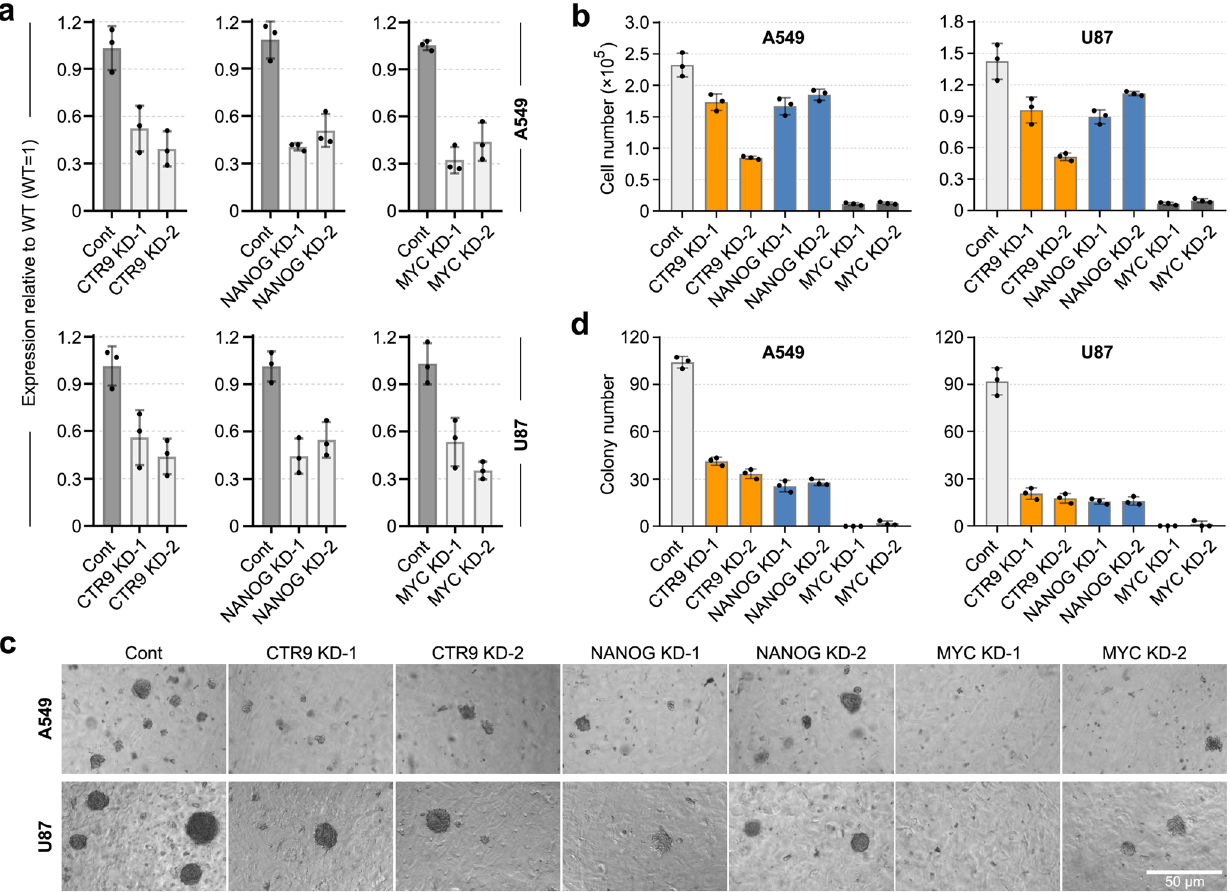
Fig. 9 The functional analysis of CORE, MYC and PAF modules in cancer cells. a qRT-PCR analysis for the knocking down of indicated gene expression in A549 and U87 cells. The major transcriptional factors of each module, Ctr9 (PAF), Nanog (CORE) and Myc (MYC), were chosen for functional analysis. Cells were infected with lentivirus carrying control and shRNAs targeting the indicated genes respectively. All data is normalized to Gapdh and shown relative to WT ESCs (set at 1.0). b The indicated cells (2000 cells per cm 2 in 6-well plates) were cultured for six days and cell numbers were counted. c The morphology of colonies formed by the indicated cell lines. Cells (1000 or 2000 cells in 48-well plates) were grown for 10 days. Scale bar, 50 μ m. d Quantitative analysis of the colony formation assay in the indicated cell lines. Experiments were repeated three times and a representative result is shown. Data in ( a – c ) represent the mean ± SD; n =